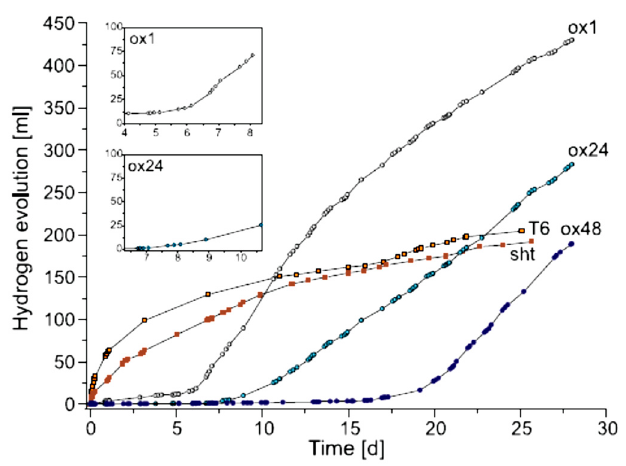
Figure 33. Hydrogen evolution of WE43 specimens in SBF at 37 °C after various heat treatment. Reproduced with permission from [164], Elsevier, 2009.